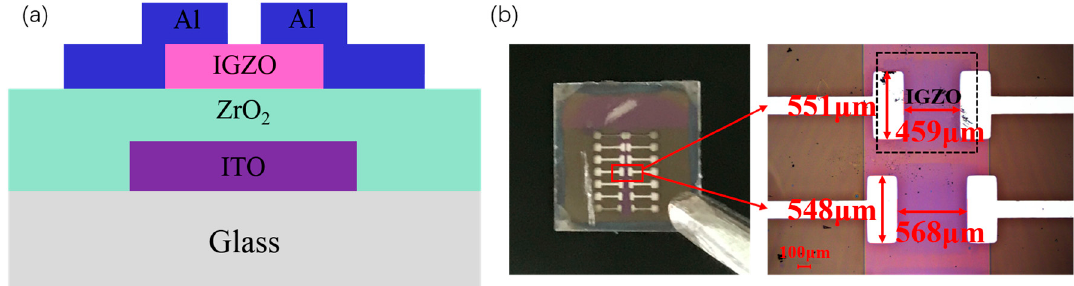
Figure 1. ( a ) The device structure of solution-processed, ZrO 2 -based TFT; ( b ) picture of solution-processed ZrO 2 TFT.